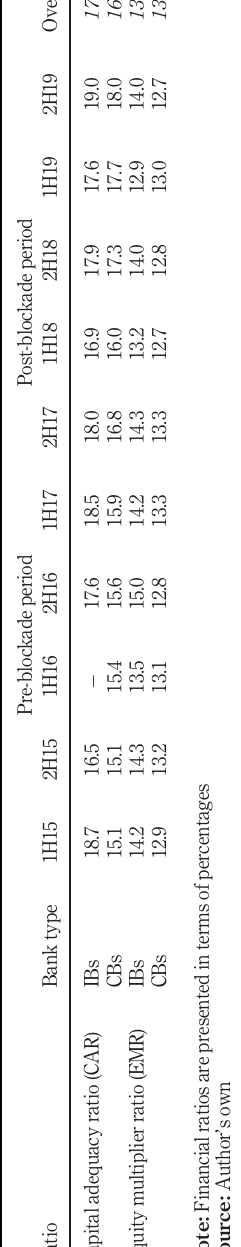
Table 2. Period-and-group- wise comparison of bank solvency